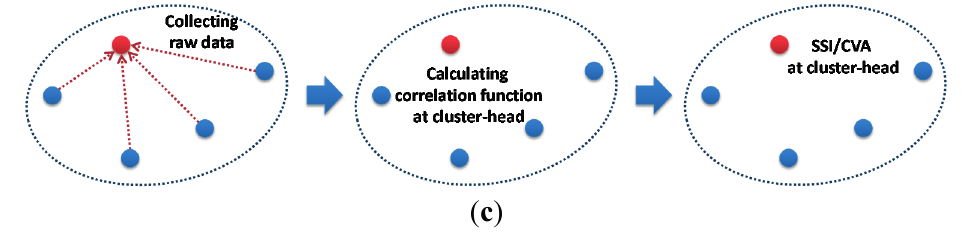
Figure 2. Decentralized coordinated processing. ( a ) Network topology; ( b ) Community-wide data processing: decentralized; ( c ) Community-wide data processing: